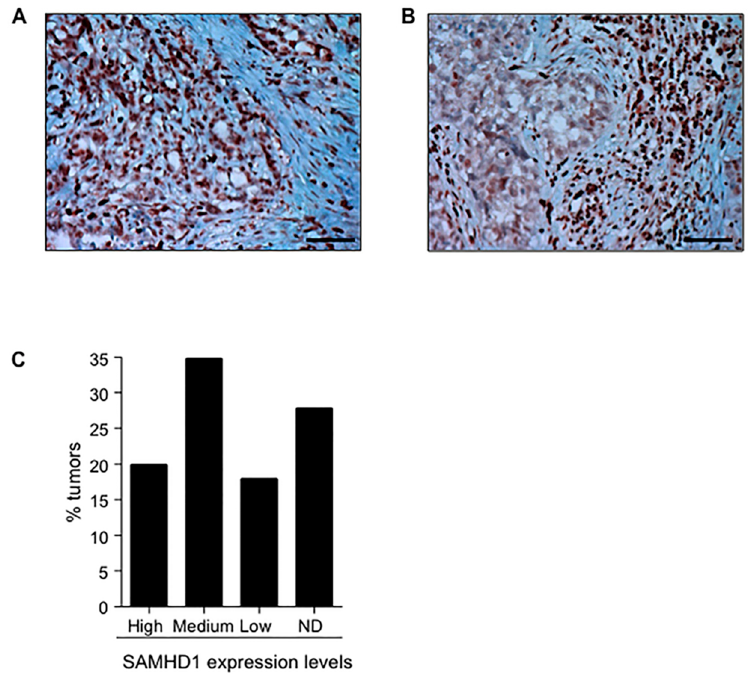
Figure 7. Expression of SAMHD1 protein in tumor samples from cancer patients. ( A – B ) IHC staining of SAMHD1 in pancreas ( A ) and lung ( B ) tumor samples. Morphology of tumor cells is shown by routine hematoxylin stain of paraffin embedded tumor sections. SAMHD1 is stained in brown. Original magnification ×200. Scale bar, 20 µm. ( C ) Percentage of tumors expressing SAMHD1, depending on its relative expression in IHC as classified in Human Proteome Atlas (www.proteinatlas.org, IHC data of SAMHD1 expression from 17 different tumor types were retrieved and classified according to protein expression levels. ND, not detected.